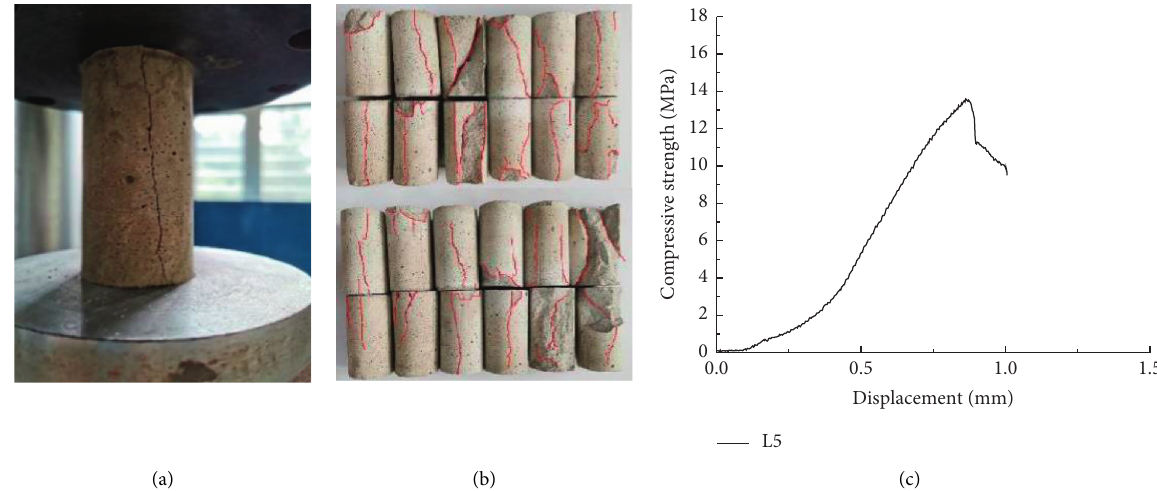
Figure 5: Compressive strength test of similar materials covered by the study. (a) Uniaxial compression test. (b) Failure of specimens. (c) Stress-displacement curve of the fifth group of specimens from the compressive test.